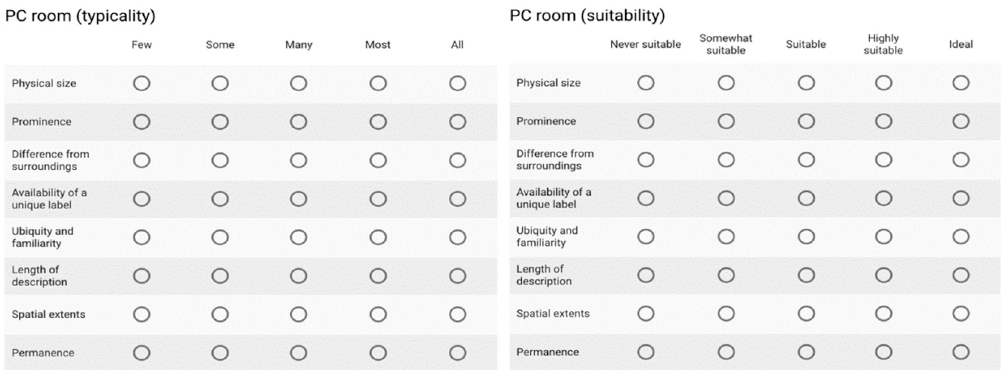
Figure 12. Questionnaire for landmarks suitability evaluation.